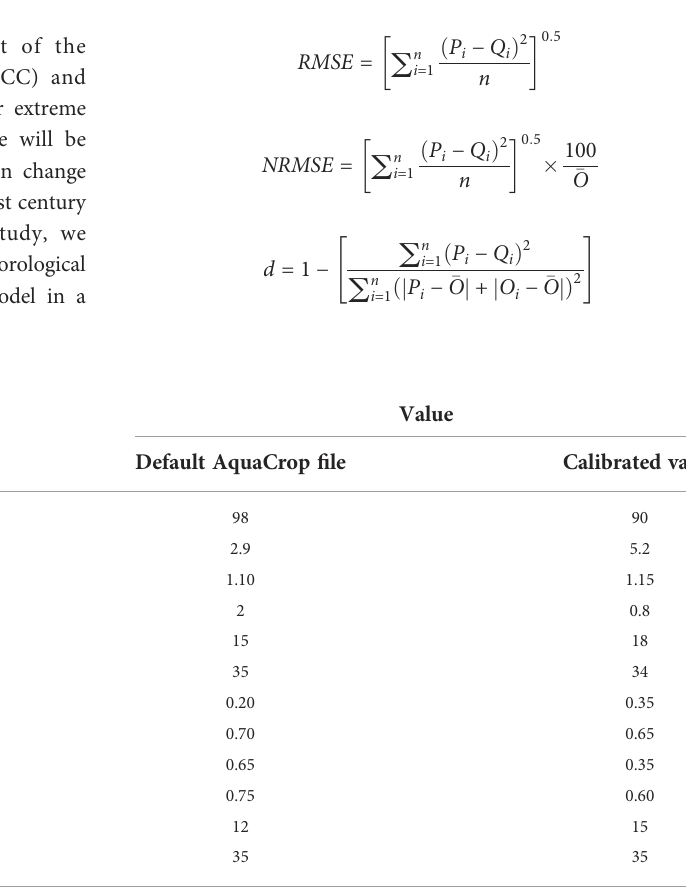
TABLE 3 Soil physical properties.